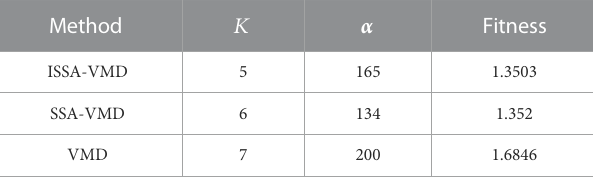
TABLE 4 Comparison of effects of different decomposition methods.